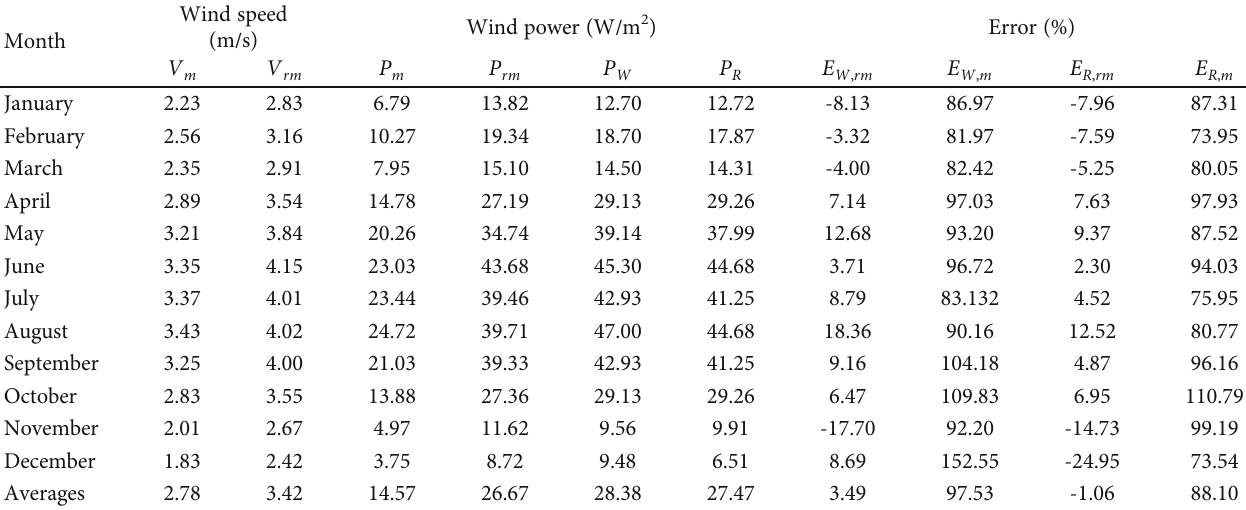
Table 6: Wind power as predicted by the models and their errors in prediction.